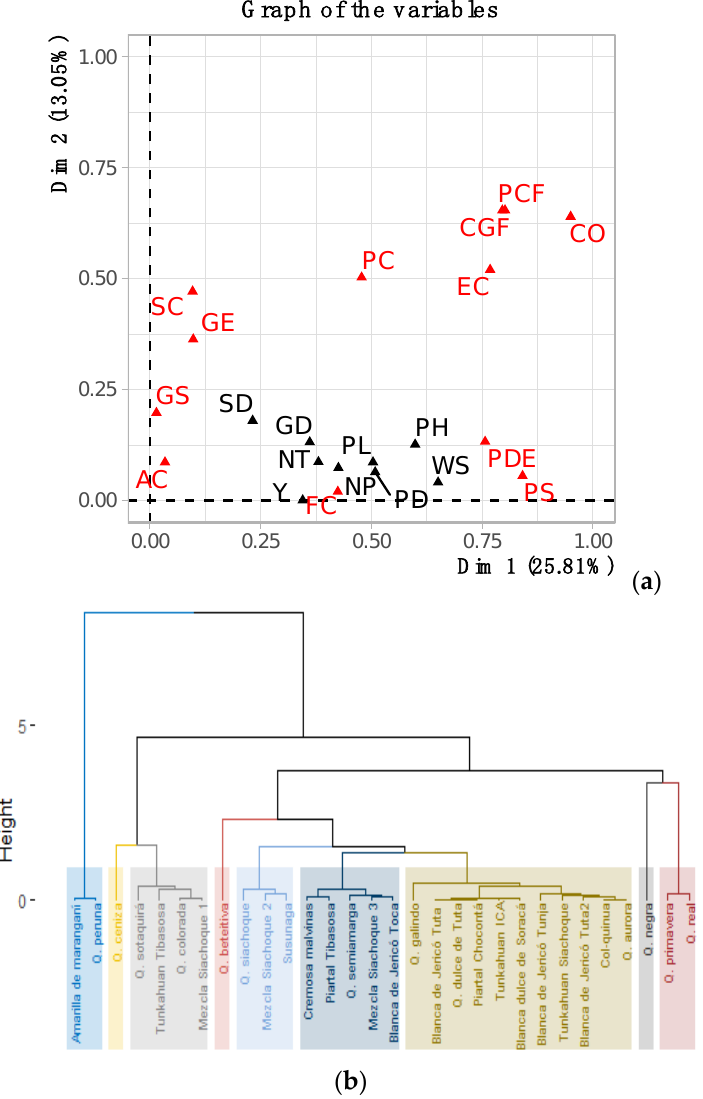
Figure 7. ( a ) Mixed factor analysis of the contribution of the variables, ordering the accessions according to the qualitative and quantitative variable; ( b ) Cluster analysis, showing nine groups of accessions formed according to the qualitative and quantitative variables.